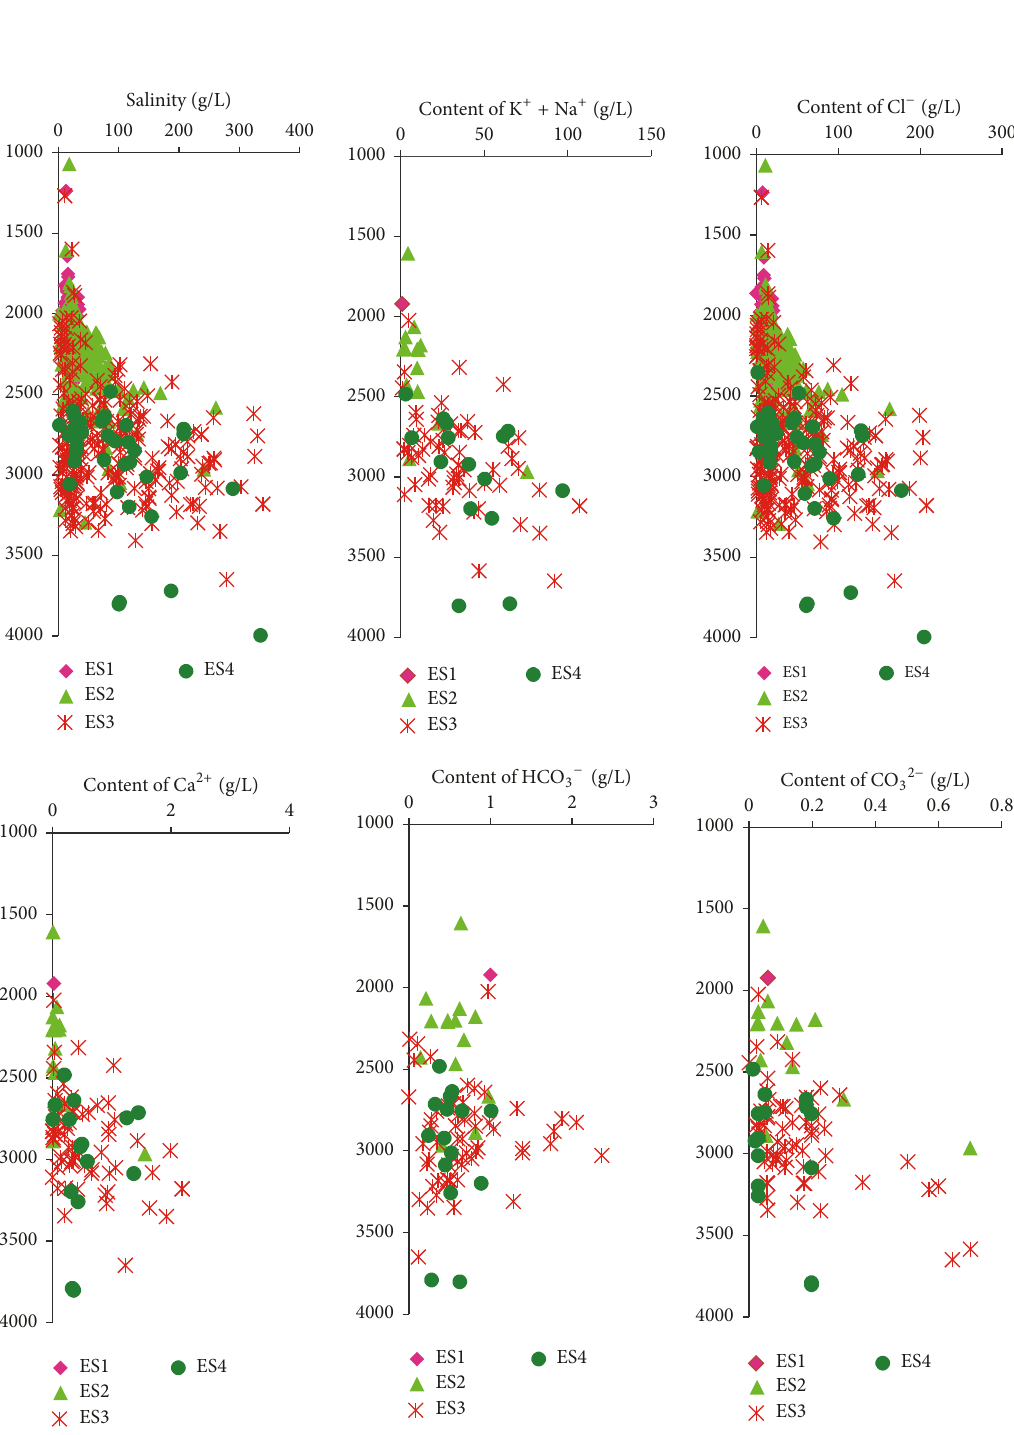
Figure 5: Changes of chemical characteristics of formation water with depth in Dongying